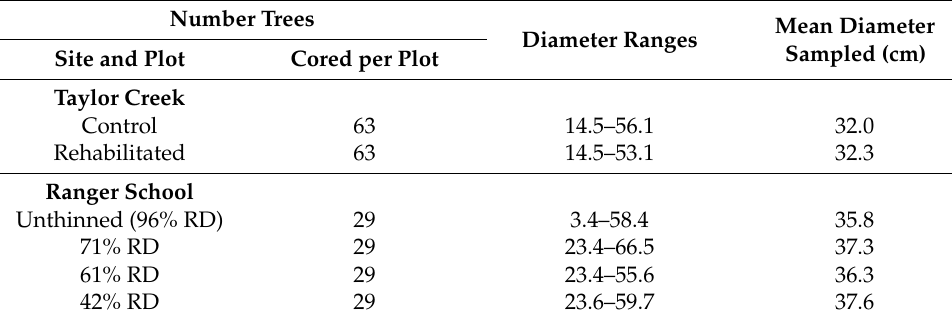
Table 1. Number and range of diameters for sampled